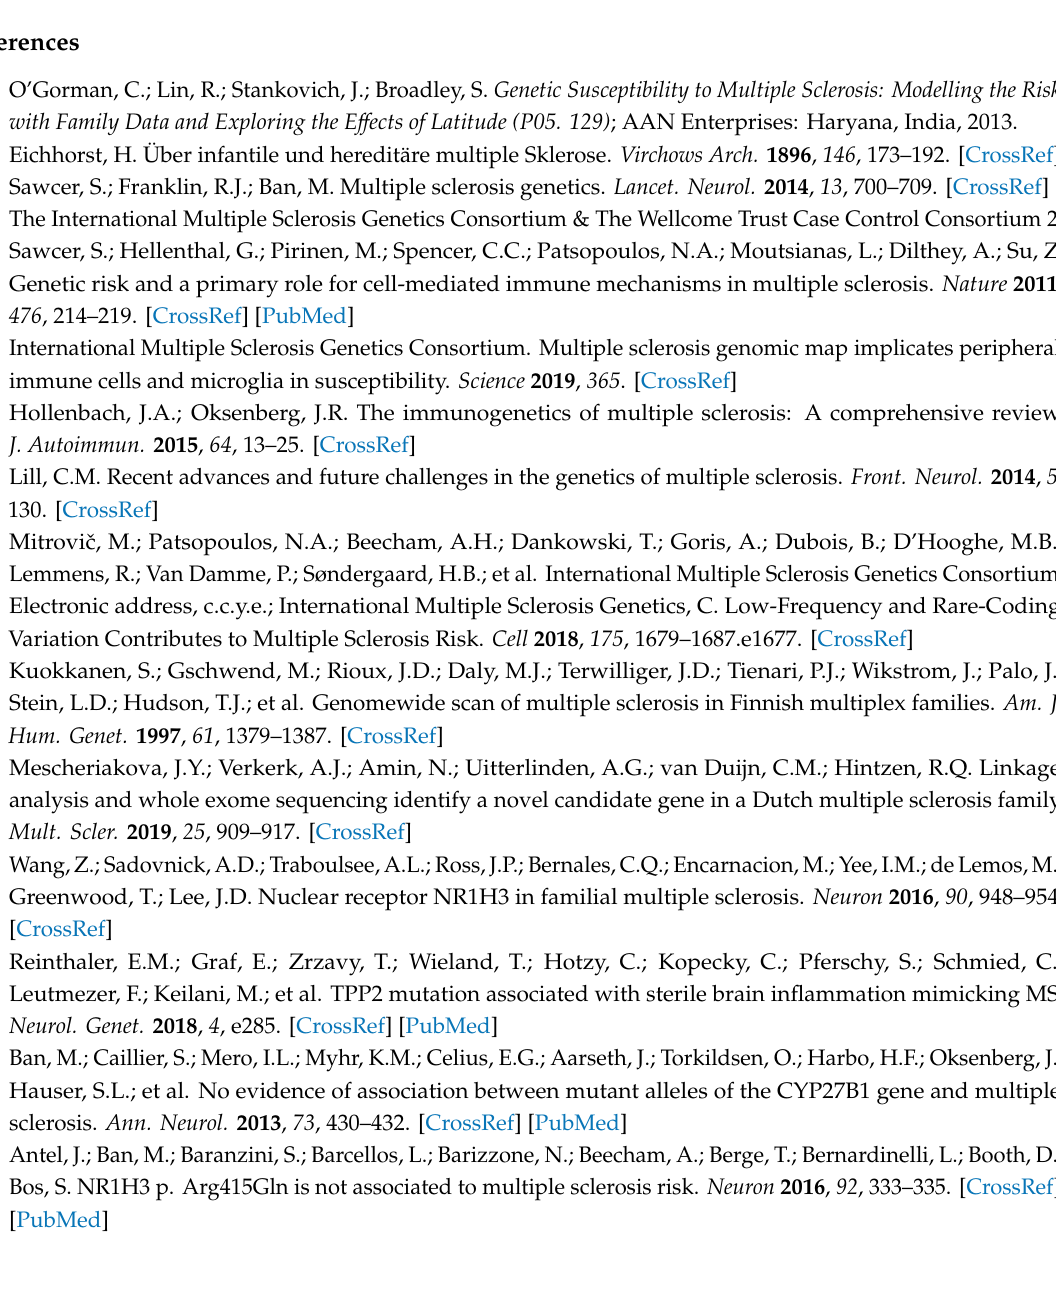
Table S1: exonic variants of the 4